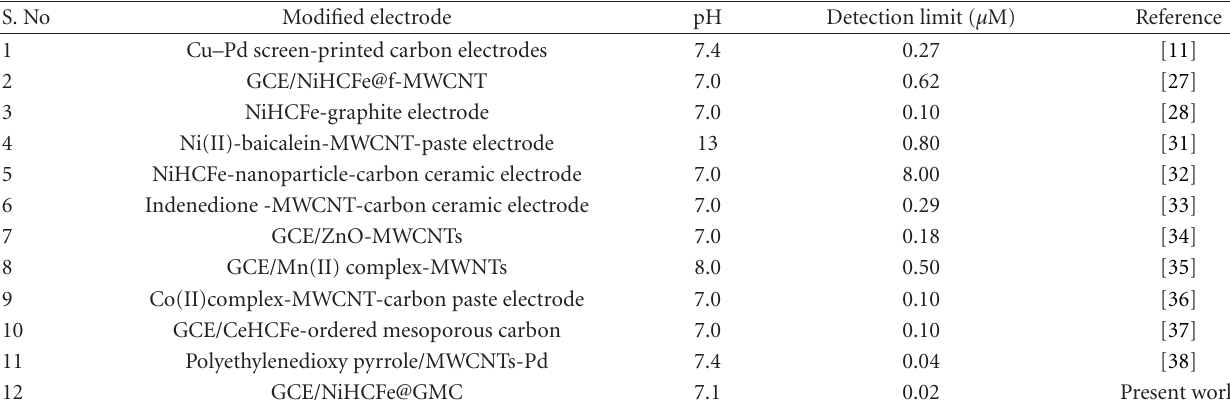
Table 1: Comparison of hydrazine detection limit on various chemically modified electrodes.